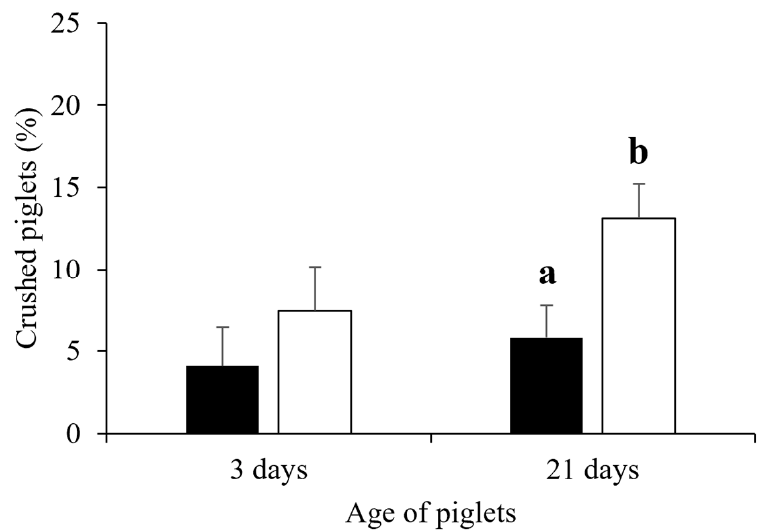
Figure 3. Proportion of piglets dead due to crushing by sows from litters raised either in the crate system (black bar) or the free-farrowing system (white bar) between 0 and 3 days of age and 0 to 21 days of age. Data are presented as Lsmeans and SEM. a and b superscripts indicate a significant difference ( p < 0.05).